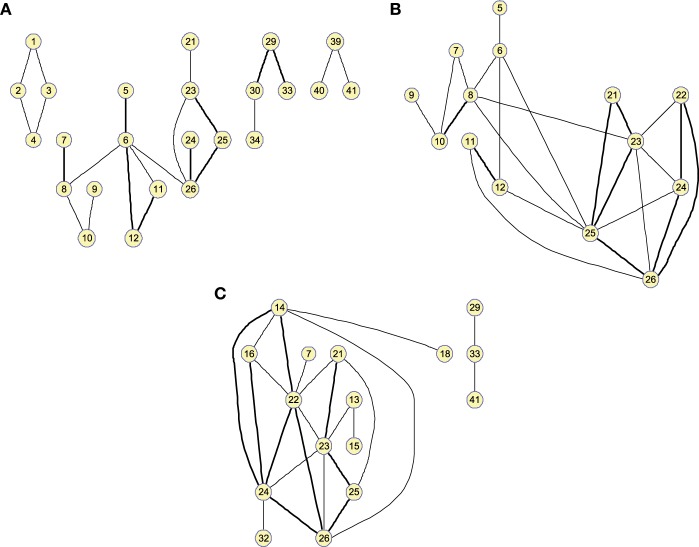
Twenty-five-arc clusters found on functional Θ^c computed up to 100 arcs for (A) Controls, (B) MCI, and (C) AD. Note that isolated nodes are not shown in the graph. Edge thickness represents the normalized strength of the connections.